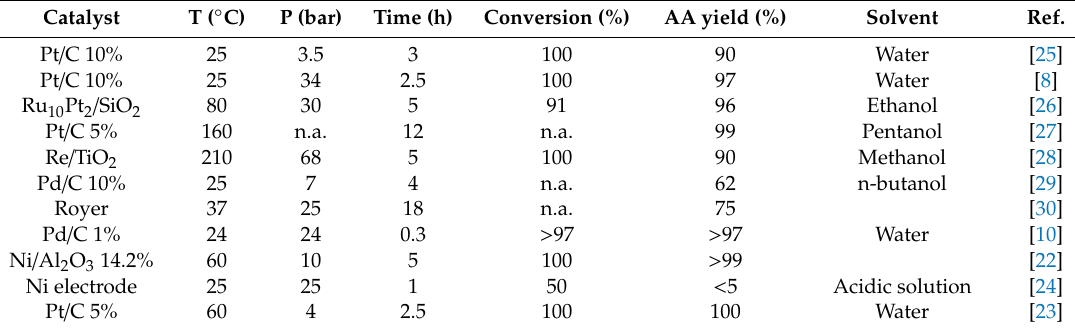
Table 1. Selected publications on muconic acid catalytic